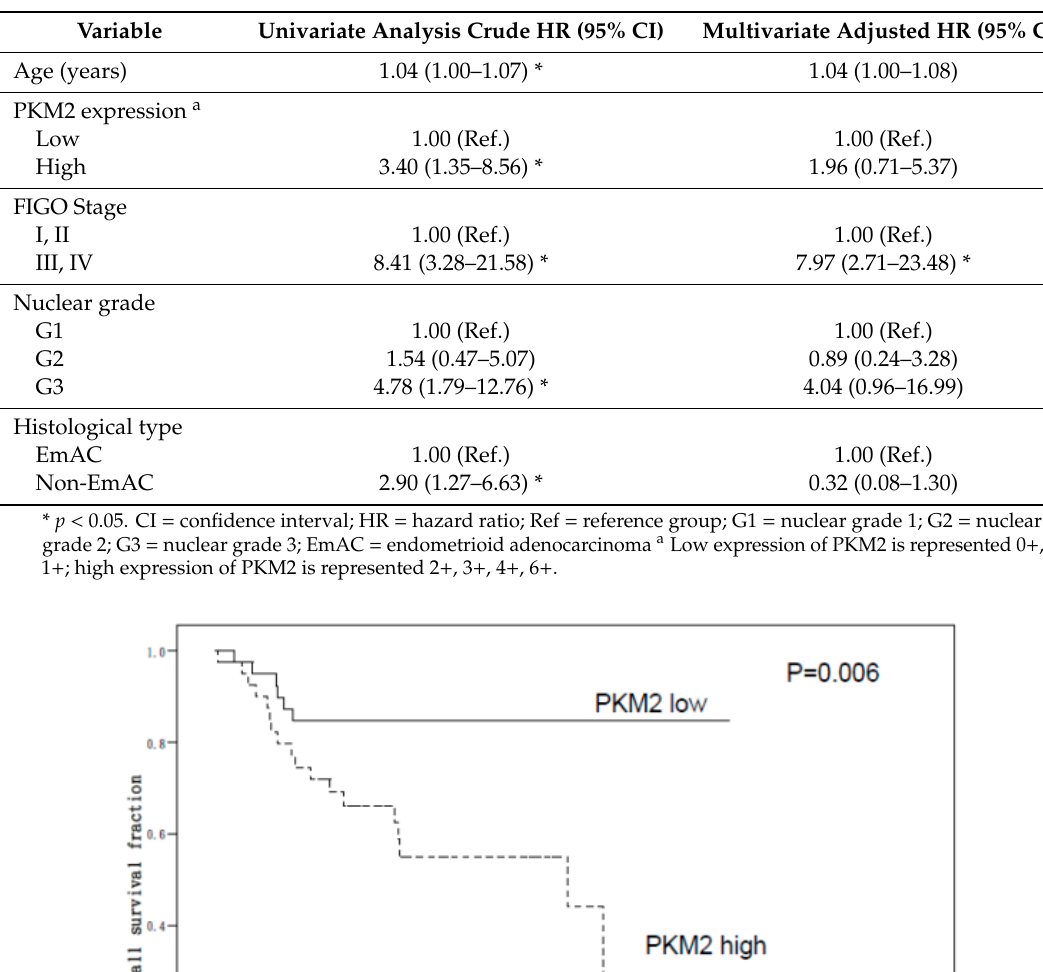
Table 3. Multivariate survival analysis of clinicopathological factors in 85 patients.